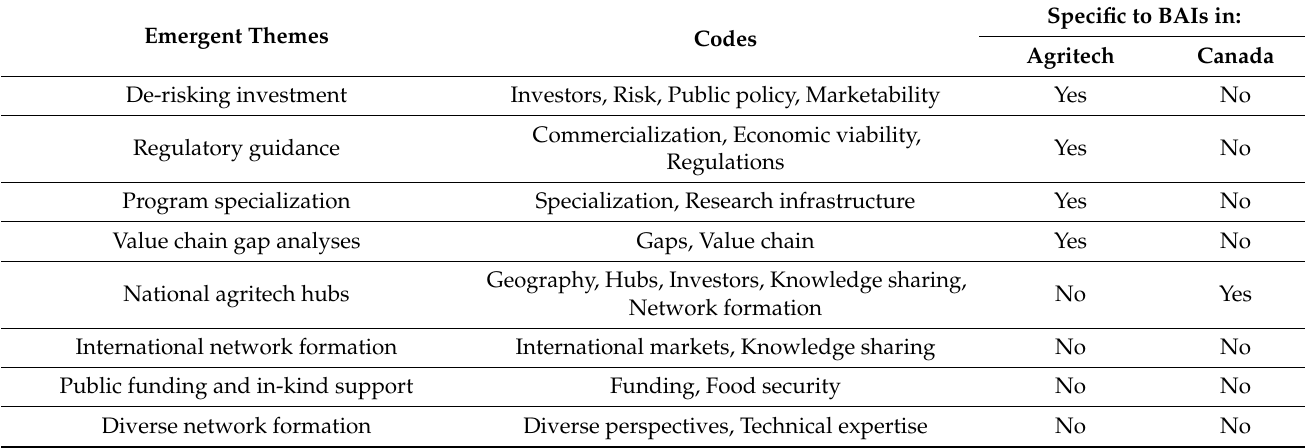
Table 5. Actions and approaches related to increasing agritech incubator and accelerator